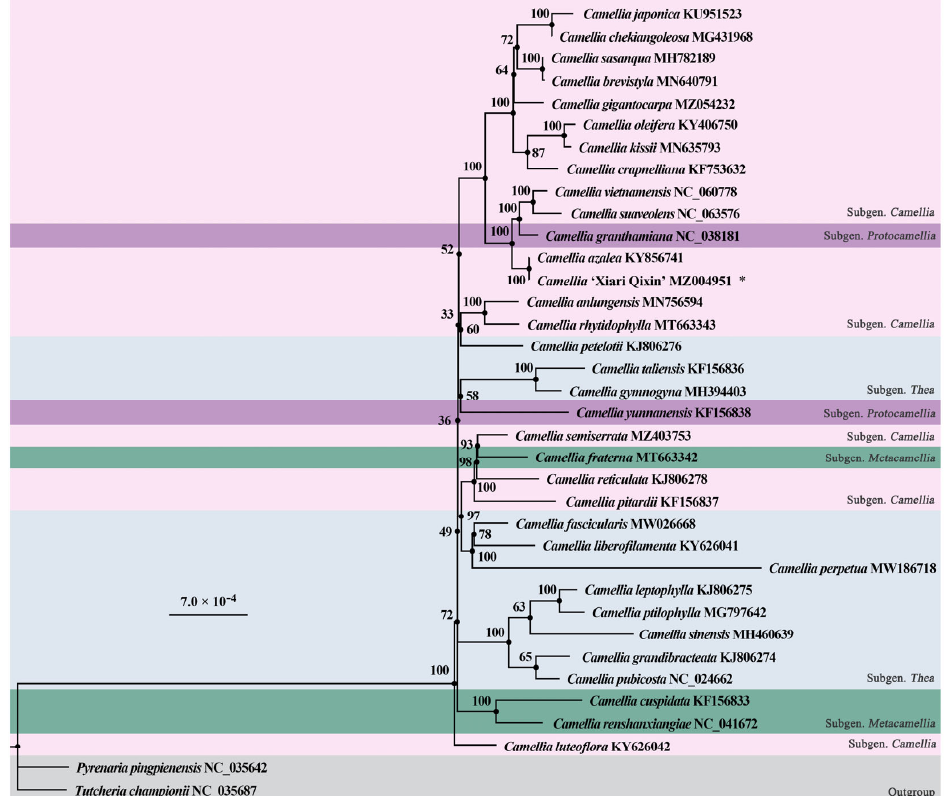
Figure 6. Phylogenetic tree of 36 chloroplast genomes inferred from maximum likelihood (ML). The bootstrap values are marked respectively at each branch node. *, the sample was sequenced and reported in this research.